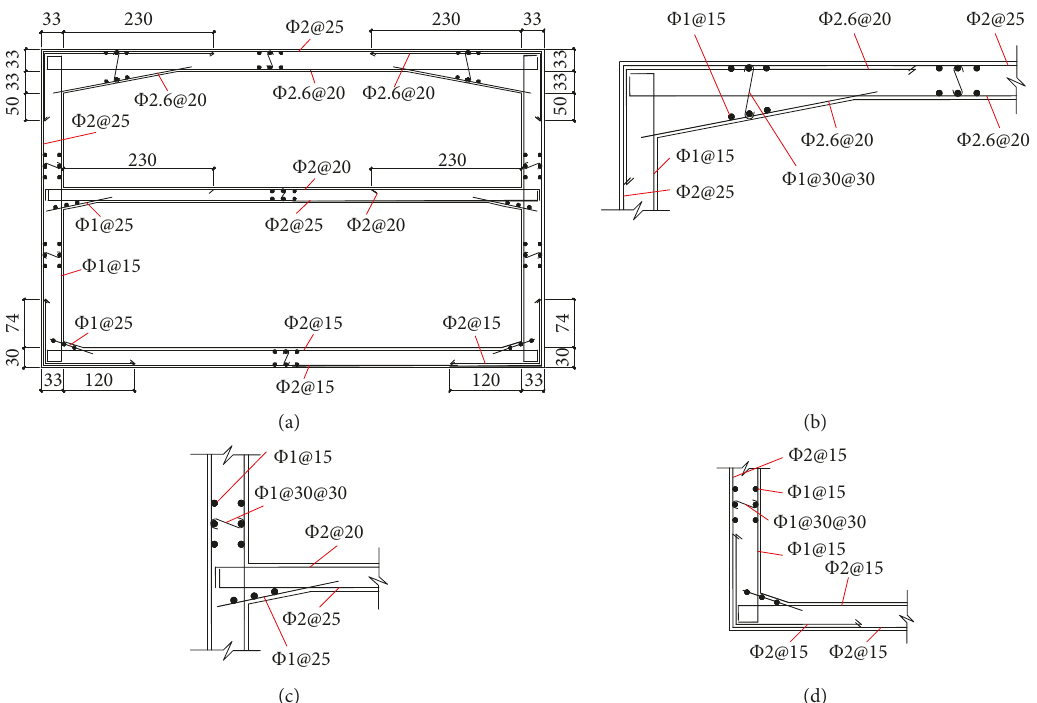
Figure 4: Reinforcement of the model structure (unit: mm). (a) The entire section. (b) Details between the roof slab and the lateral wall. (c) Details between the middle slab and the lateral wall. (d) Details between the bottom slab and the lateral wall.